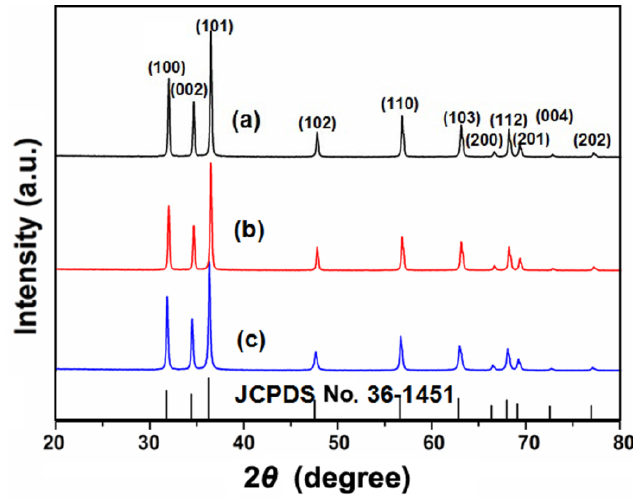
Figure 4. X-ray diffraction (XRD) spectrums of annealed ZnO powder at different CA/ZA molar ratios: ( a ) 0:1; ( b ) 0.2:1; ( c ) 1:1.